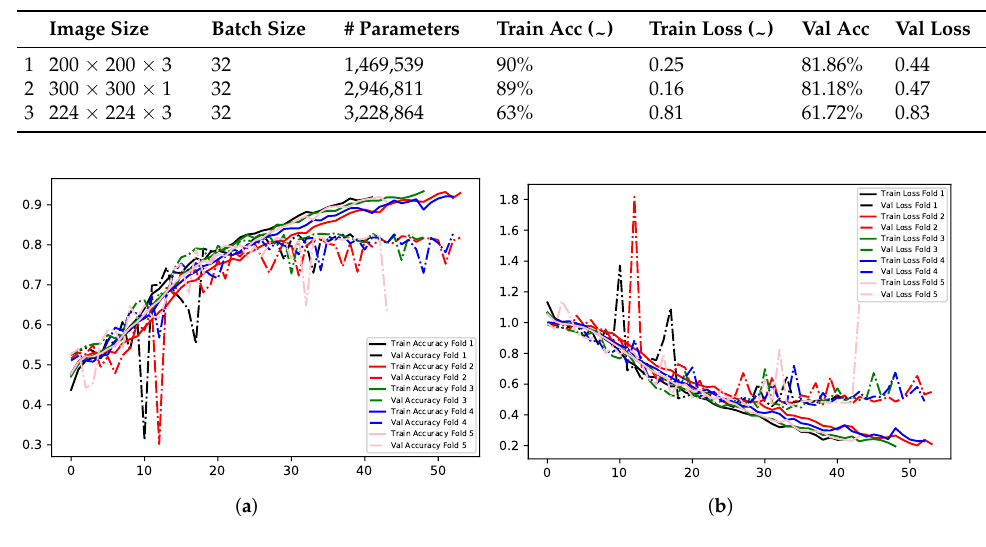
Figure 12. Model B Experiment 1 Results. ( a ) Accuracy. ( b ) Loss.